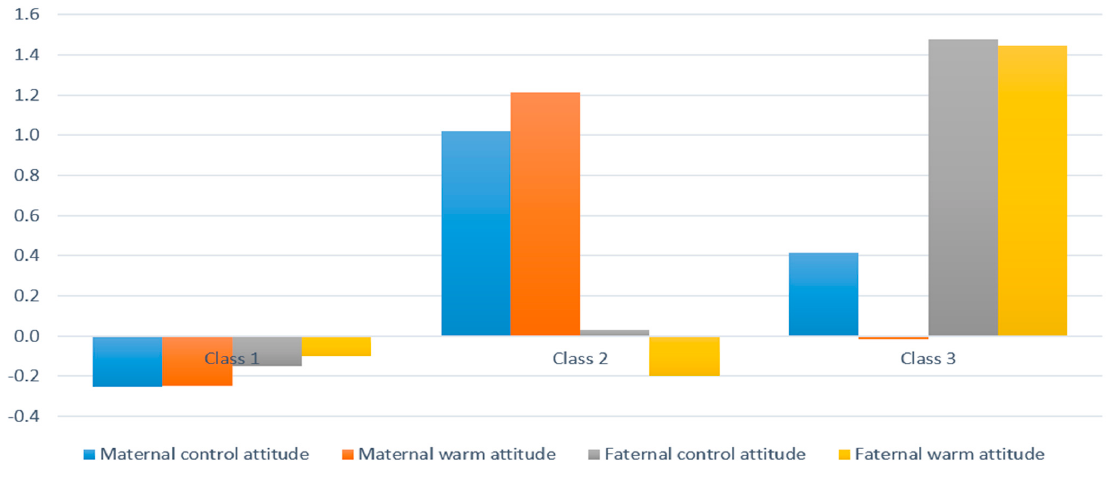
Figure 1. Latent class of child-rearing attitude (5th wave). Table 3. Model fit of latent profile analysis of child-rearing attitude (8th wave).